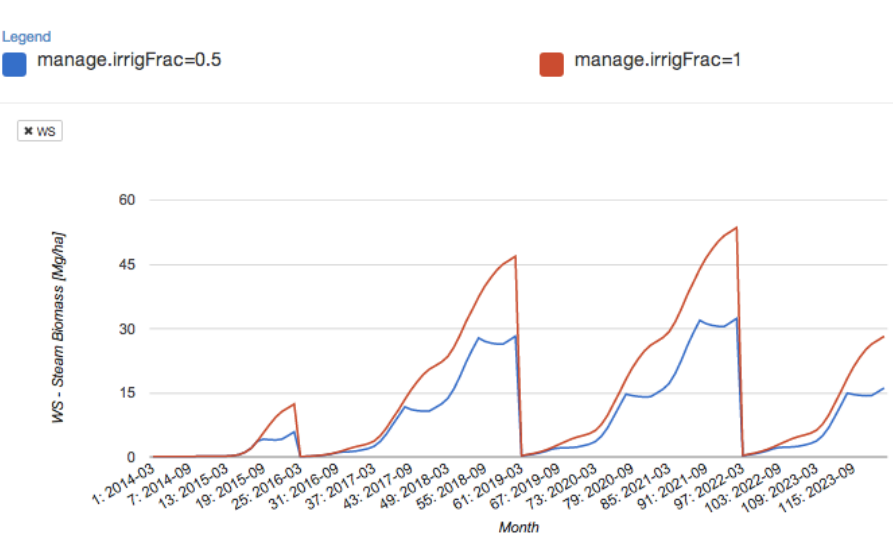
Figure 4. The effects of the irrigation fraction on stem biomass